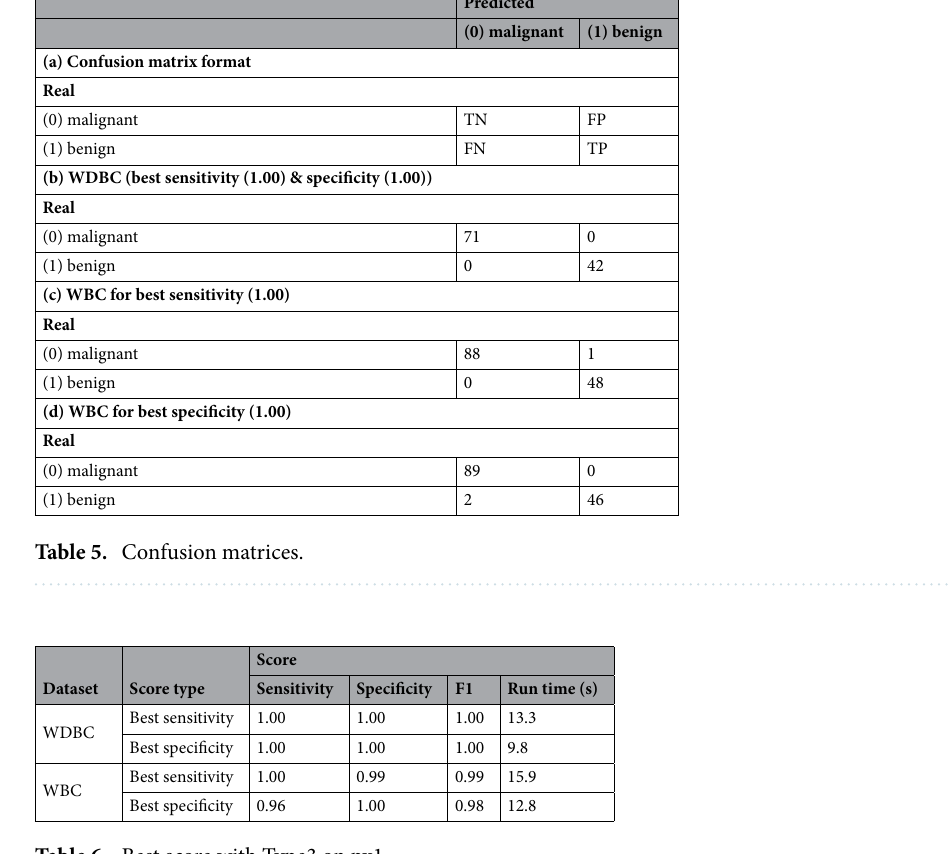
Table 6. Best score with Type3 on px1.